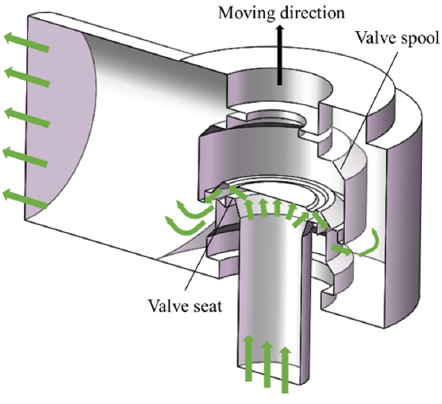
Figure 6. Structure of the safety relief valve.